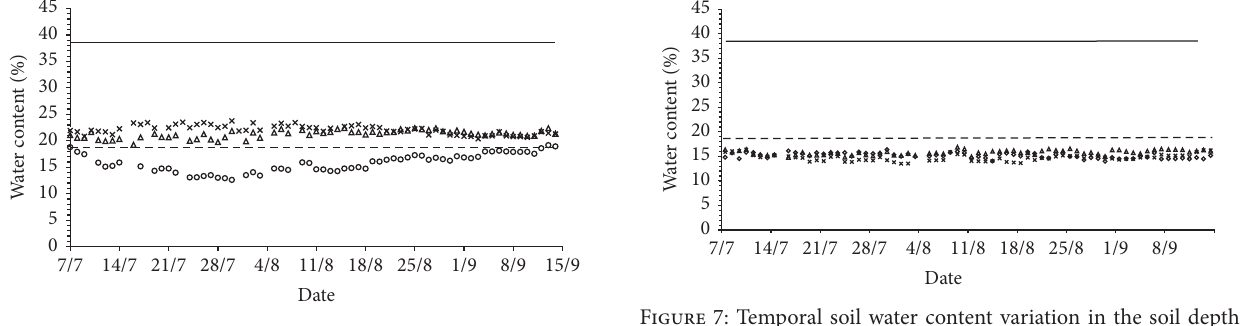
Figure 4: Temporal soil water content variation in the soil depth 𝑍 = 10 cm: at the inlet 𝑋 = 0 ( × ), at the behalf 𝑋 = 𝐿/2 ( 󳵻 ), and at the lateral end tip 𝑋 = 𝐿 (o)against (𝜃 dashed lines.